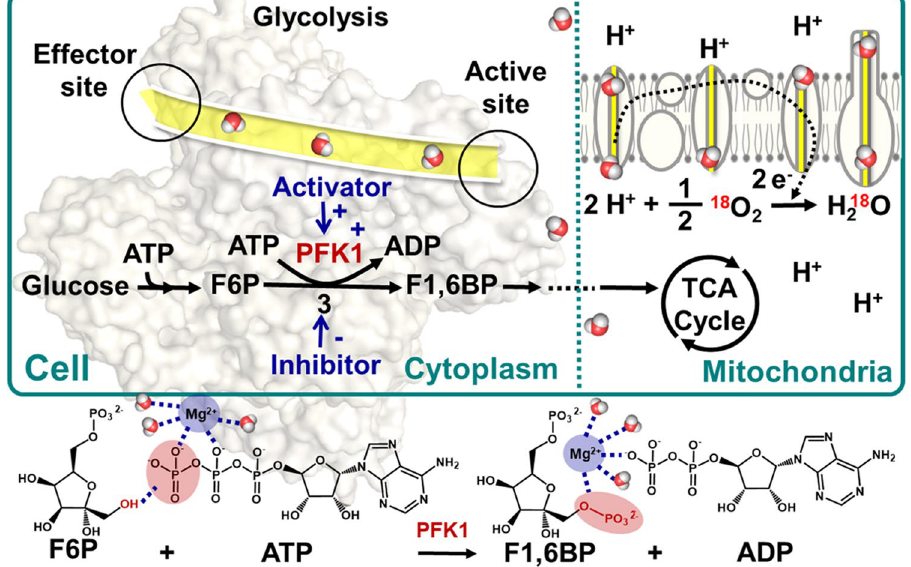
Figure 2. Cellular respiration is a metabolic pathway consisting of two major locations, in the cellular cytoplasm for glycolysis and in mitochondria, which produce ATP, in which the “committed” step of glycolysis at pacemaker PFK-1 activity is modulated by allosteric activators, including ADP, F6P, and phosphate (P i ), as well as those inactivators of citrate, fatty acids, and ATP. In the whole reaction, water is necessary. There are water channels (shaded yellow) in the protein to regulate the distribution of